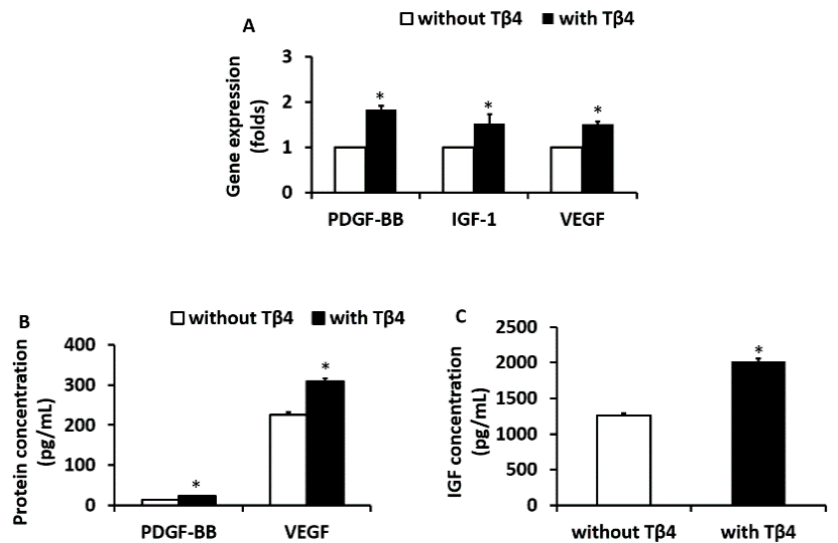
Figure 2. ( A ) Gene expression levels of platelet derived growth factor-BB (PDGF-BB), insulin like growth factor-1 (IGF-1), and vascular endothelial growth factor (VEGF) from T β 4-treated and non- T β 4 treated EPCs. Protein concentrations of PDGF-BB and VEGF ( B ) or IGF-1 ( C ) from T β 4-treated and non-T β 4 treated EPCs as determined by respective ELISA kit ( n = 8) (*: p < 0.05, vs. non-T β 4 treated EPCs).